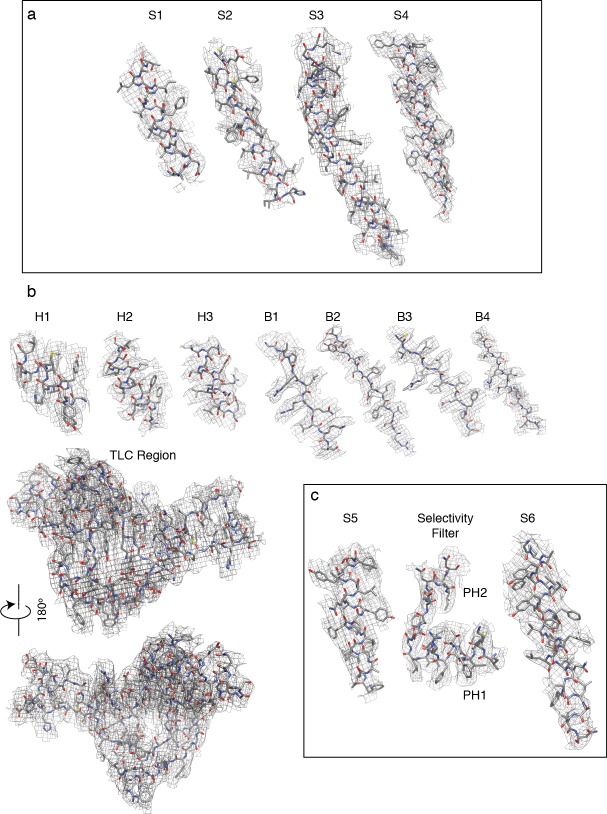
Quality of the EM density map and fit of model.(a) EM density maps are shown for the polycystin 2-l1 monomer in the Voltage Sensor Like Domain for helices S1-S4. (b) The PMD with all secondary structural elements and a general scheme of the three loops that comprise the Three Leaf Clover (TLC) region (left and below). (c) The Pore Domain for helices S5, S6 and the selectivity filter with pore-helices 1 and 2 (PH1 and PH2).